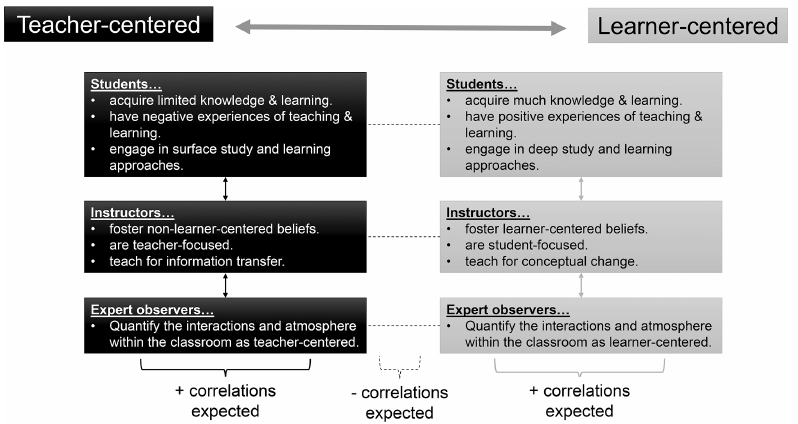
Fig 1. The proposed one-dimensional learner- to teacher-centered framework. Examples of student behaviors and instructor practices at the learner-centered end (in gray) juxtapose those that are more teacher-centered (black) at the other end of the framework. Learner-centered descriptors (gray) were expected to positively correlate with each other, while teacher-centered descriptors (black) were expected to positively correlate with each other. Negative correlations (dashed line) were expected between two related but contrasting descriptors, as both would fall on opposite ends of the learner- to teacher-centered framework. For example, deep approaches are more learner-centered, while surface approaches are more teacher-centered; a student that engaged in deeper learning approaches would not be expected to engage in as many surface approaches, or vice versa.